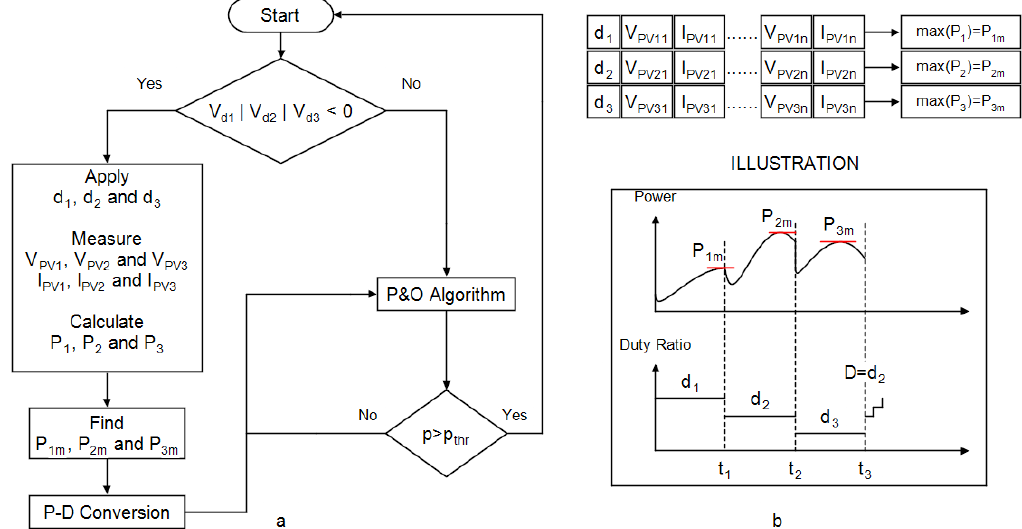
Figure 8. ( a ) Flowchart of the proposed algorithm; ( b ) Illustration of the algorithm operation.